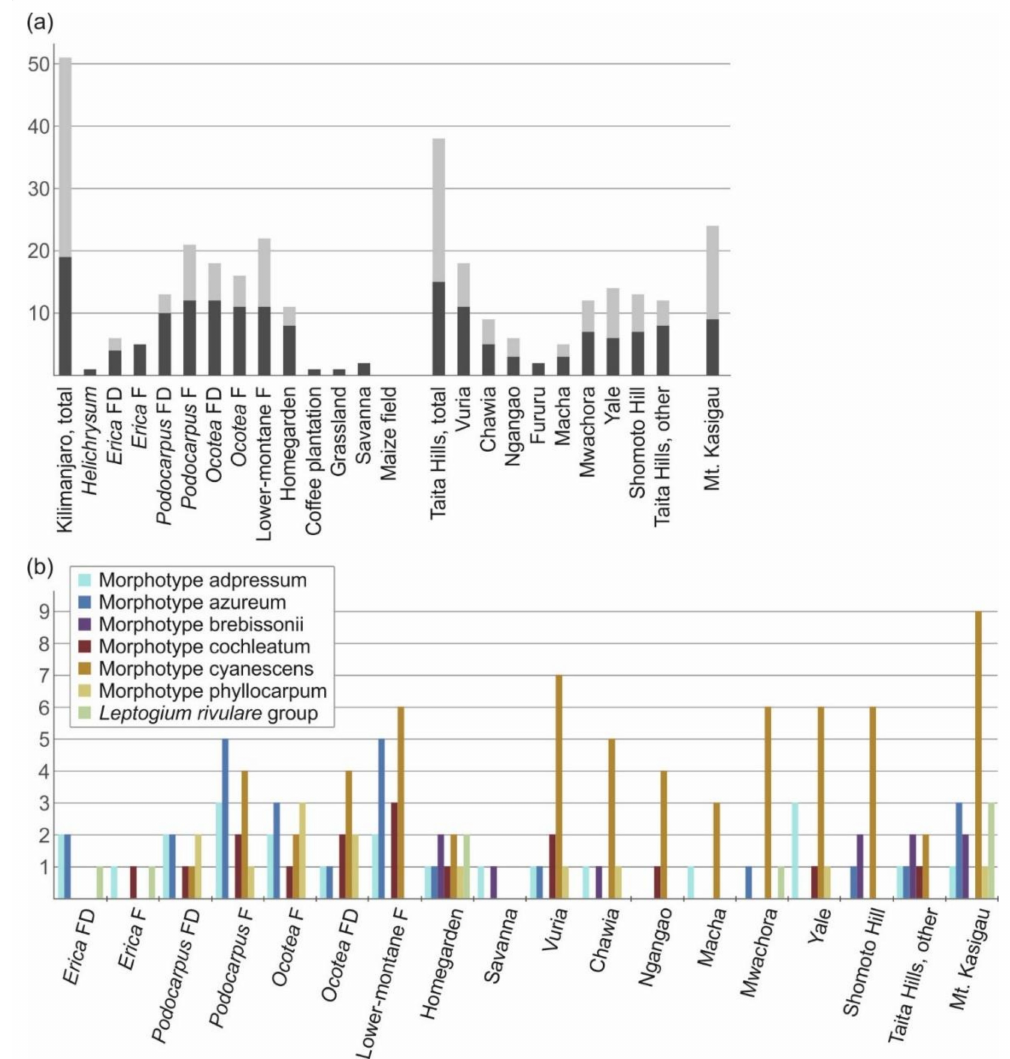
Figure 8. Leptogium diversity in different habitats of East African mountains, represented by different ecosystem types on Mt. Kilimanjaro, different forest fragments in the Taita Hills, and Mt. Kasigau as a whole. ( a ) Total species diversity of Leptogium in each habitat type (dark grey = proportion of classical, previously known species; light grey = proportion of new diversity discovered in this study). ( b ) Distribution of the common Leptogium morphotypes among the habitat types (including habitats with at least three different morphotypes). F = forest; D = disturbed